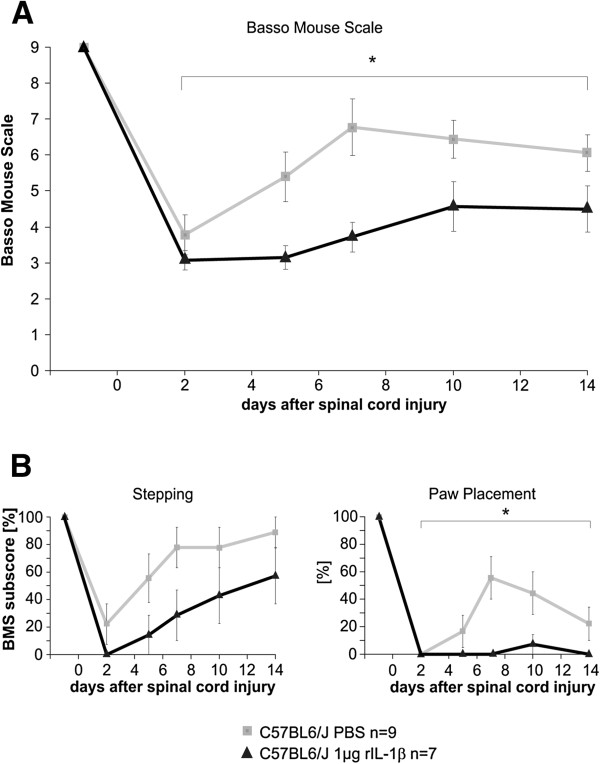
Application of recombinant IL-1β impairs neurological outcome after spinal cord compression injury. (A) Locomotion analysis using the Basso Mouse Scale (BMS) showed significant worsening of neurological outcome after spinal cord compression injury (SCI) and local administration of recombinant IL-1β (rIL-1β) in Gelfoam directly after SCI. The rIL-1β-treated mice scored more than 1 point of the BMS less than control mice (scoring respectively 4.5 and 6), most probably reflecting lack of coordination and consistent plantar stepping in the treated mice. (B) The paw positioning subscore differed significantly between the two groups, while the stepping subscore did not. *P <0.05, two-way analysis of variance.